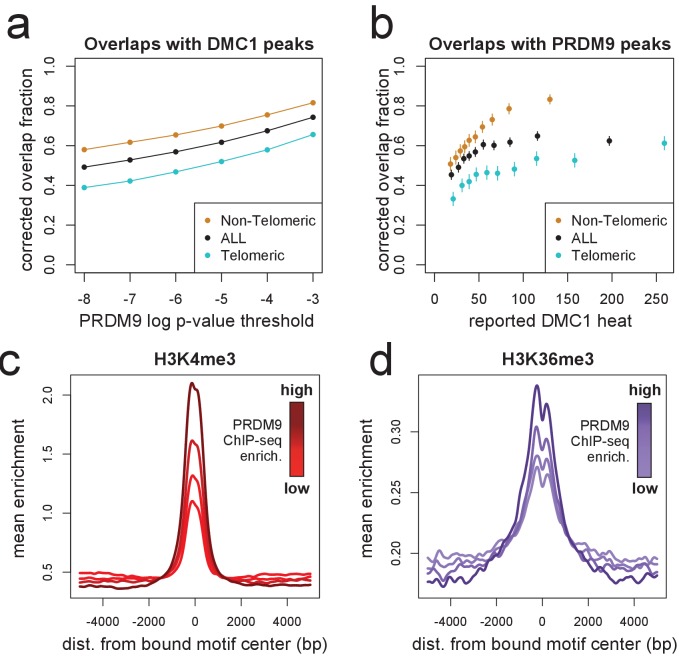
DMC1, H3K4me3, and H3K36me3 signals surrounding human PRDM9 peaks.(a) A comparison our autosomal PRDM9 peaks, called at various p-value thresholds ranging from 10−8 to 10−3 (minimum peak separation 250 bp), to a set of published DSB hotspots corresponding to the human A allele (from a set of 18,343 ‘Intersect’ DMC1 hotspots found in multiple individuals, filtered to remove hotspots wider than 3 kb; Pratto et al., 2014). Hotspots were further split into subsets occurring within 15 Mb of a telomere (turquoise) or not (orange). ‘Overlap’ requires a PRDM9 peak center to fall within a reported DMC1 hotspot interval, and overlap fractions were corrected downward to account for chance overlaps (see Materials and methods). (b) DMC1 hotspots were split into decile bins by reported DMC1 heat, and the proportion of hotspots in each bin overlapping one or more of our PRDM9 peaks is indicated (error bars represent two standard errors of the proportion). (c) Profile plot showing the mean H3K4me3 enrichment (measured in HEK293T cells transfected with human PRDM9) at bound human motifs conditioned not to have any H3K4me3 enrichment measured in untransfected cells, and split into quartiles of increasing PRDM9 enrichment (smoothing: ksmooth, bandwidth 200) (d) Profile plot showing the mean H3K36me3 enrichment (measured in HEK293T cells transfected with human PRDM9) at bound human motifs conditioned not to have any H3K36me3 enrichment measured in untransfected cells, and split into quartiles of increasing PRDM9 enrichment. NB: absolute enrichment values cannot be compared across samples. (smoothing: ksmooth, bandwidth 25) .